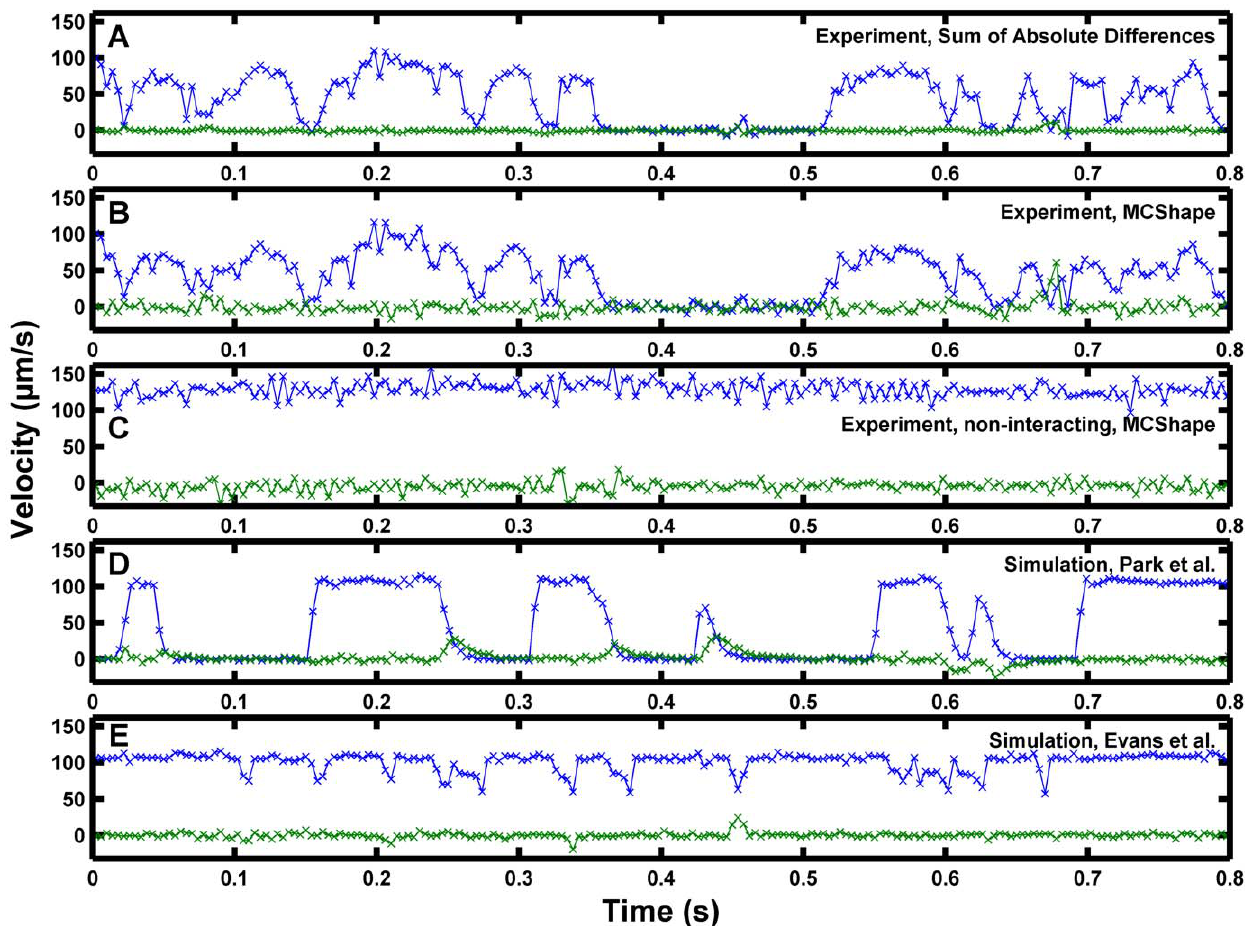
Figure 7. High temporal resolution comparison of simulation results to the data of Park et al. [ 23 ] . Experiments and simulations were performed with S=50 s 2 1 , R=4.9 m m, n L u =90 sites/ m m 2 , and n R u =95 sites/ m m 2 . The sampled flow-direction velocity (V S,X , blue) and the sampled perpendicular velocity (V S,Y , green). (A) Results for an experimental microbead using the original sum-of-absolute-differences tracking algorithm. (B) The same experimental microbead was tracked using the centroid-based MCShape algorithm. (C) Tracking results using MCShape for an apparently non-interacting experimental microbead in the same video segment. (D) Simulation results using the Bell slip bond model, (3), dissociation parameters from Park et al. [23]. The comparison demonstrates the model recreates microbead motions well to a first approximation. (E) Simulation results using catch-slip model, (4), dissociation parameters from the discussion of the biomembrane force probe results by Evans et al. [22]. The results demonstrate that if the parameters discussed by Evans et al. [22] are true measures of monomeric bond dissociation under force, they would be difficult to detect by a pause time analysis of flow cell assay data.